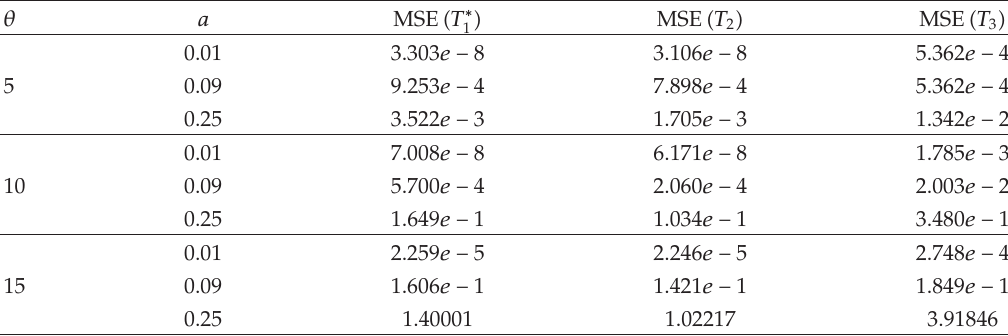
, T 2 , and T 3 when n (cid:5) 1